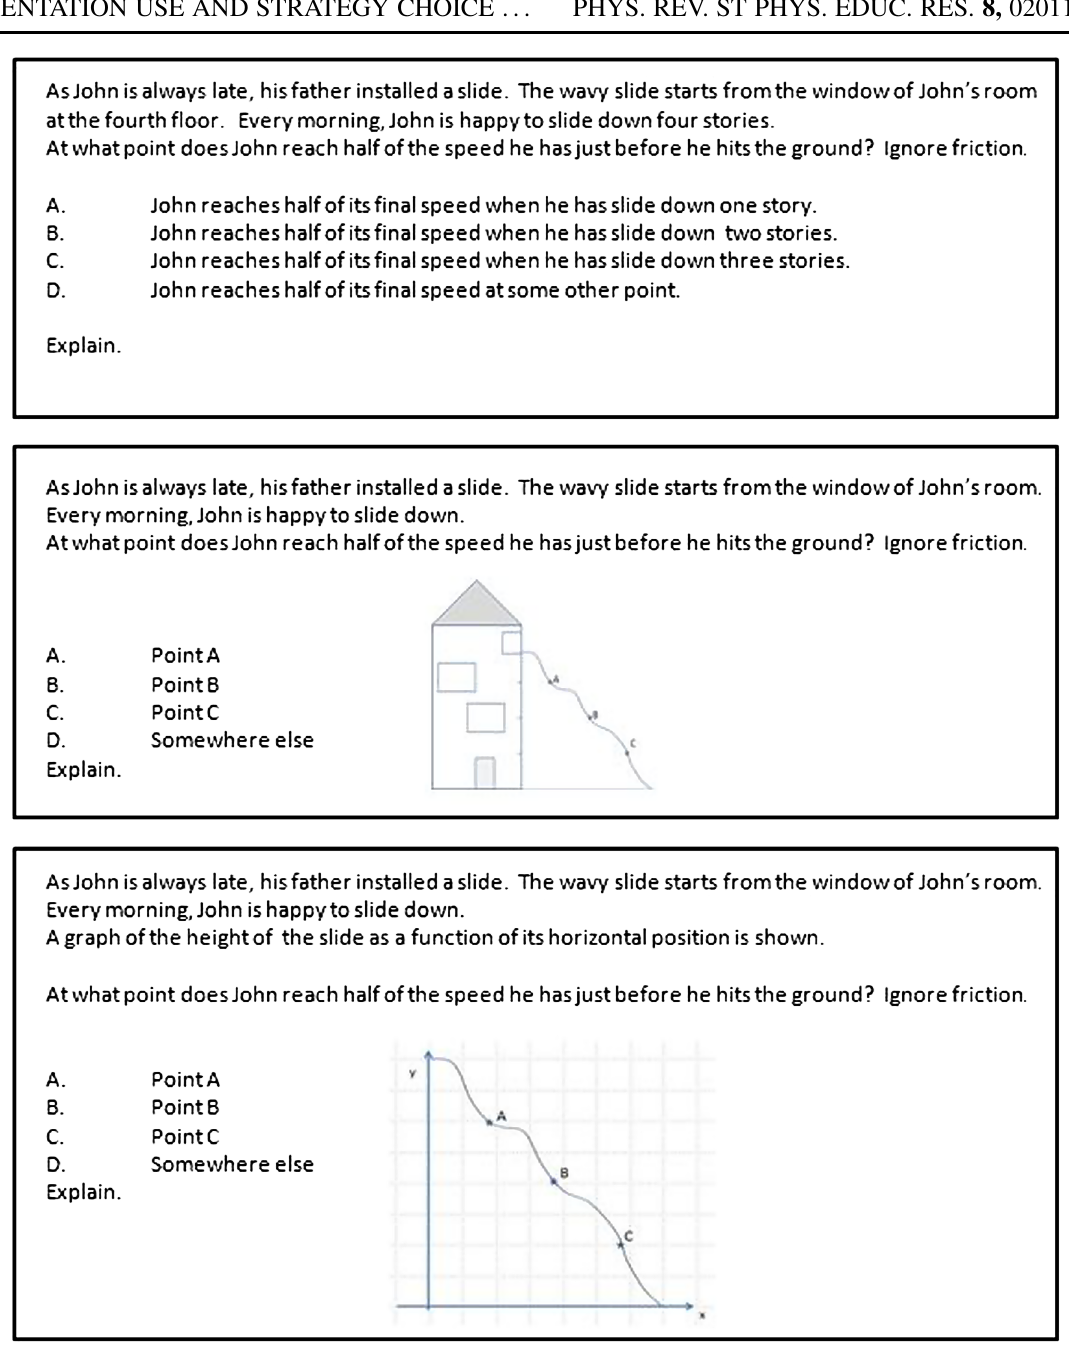
FIG. 4 (color online). Verbal, graphical, and pictorial representation of third